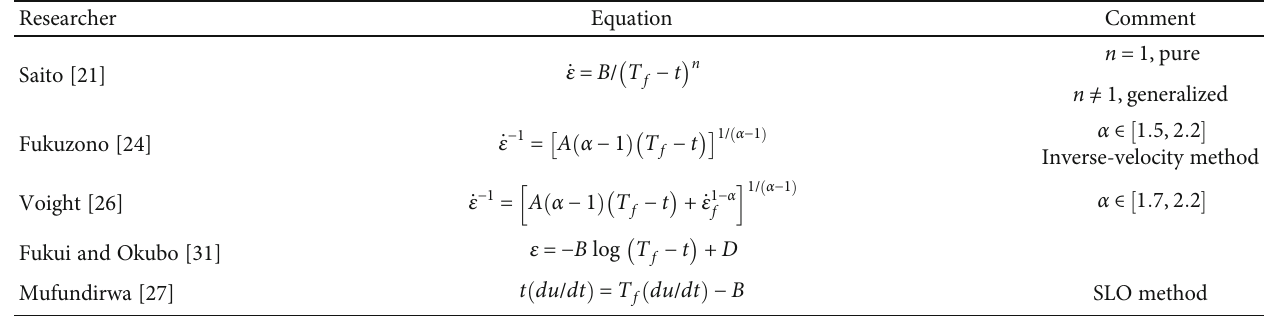
Table 2: Time to failure prediction method.